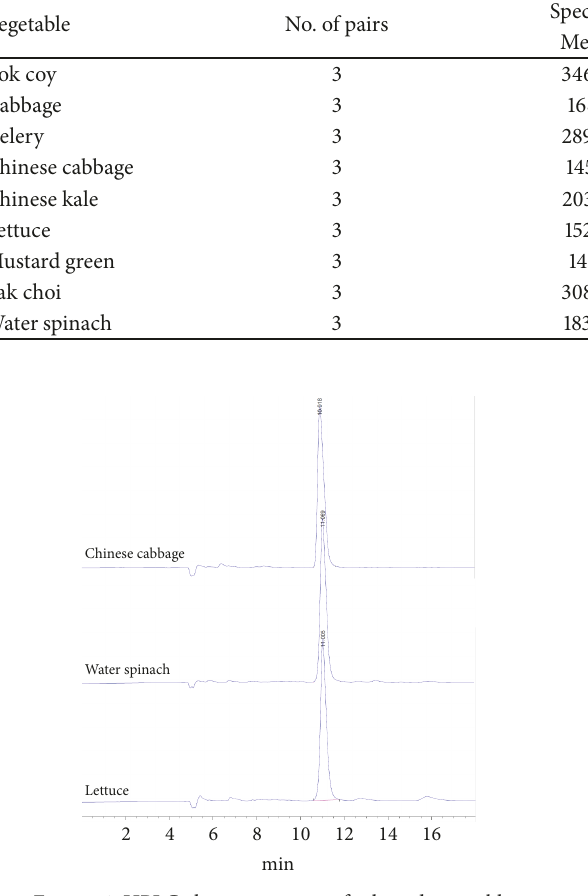
Figure 1: HPLC chromatograms of selected